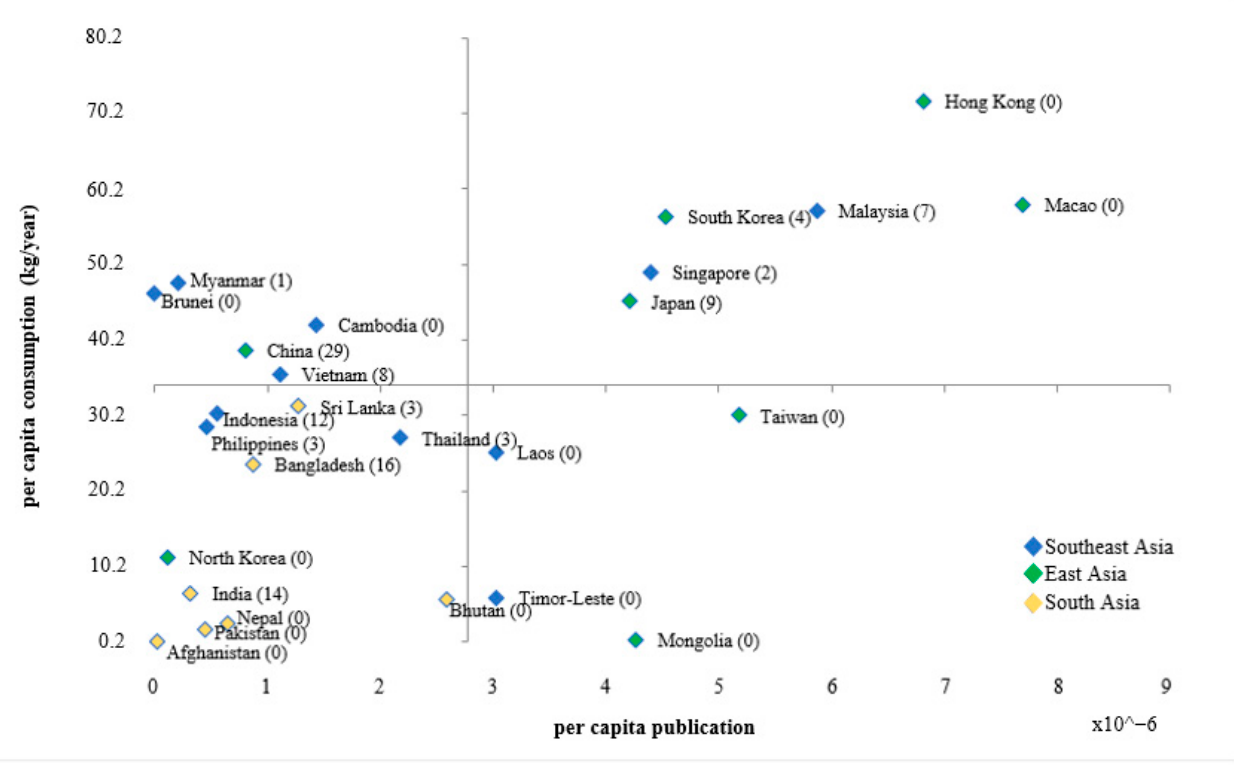
Figure 2. Variations in per capita publication × 10 − 6 versus per capita aquatic food consumption (kg/capita/year). Data on per capita aquatic food consumption was taken from [61]; per capita publication was based on the potential publications to aquatic food consumption behaviour identified through the Scopus database; the bracket indicates the number of publications selected in the scoping review; the Maldives being an outlier was excluded.